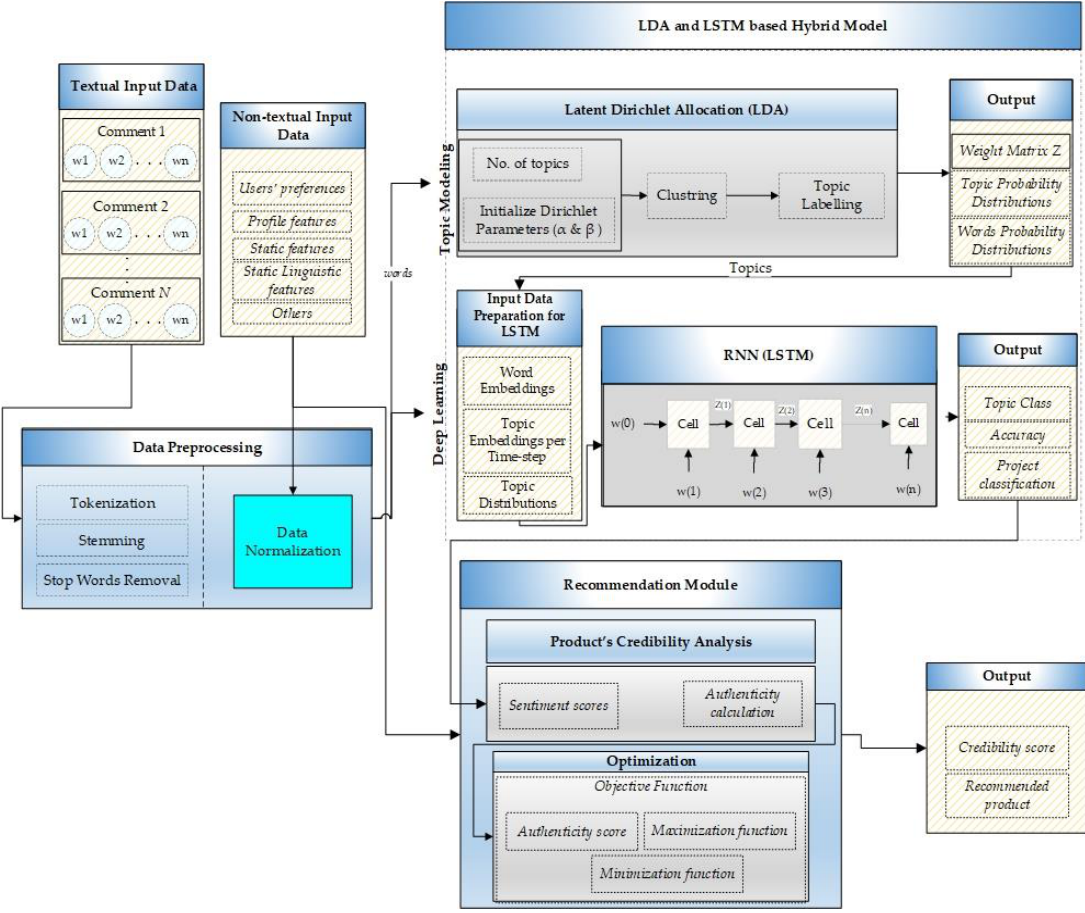
Figure 3. Detailed view of the proposed approach.